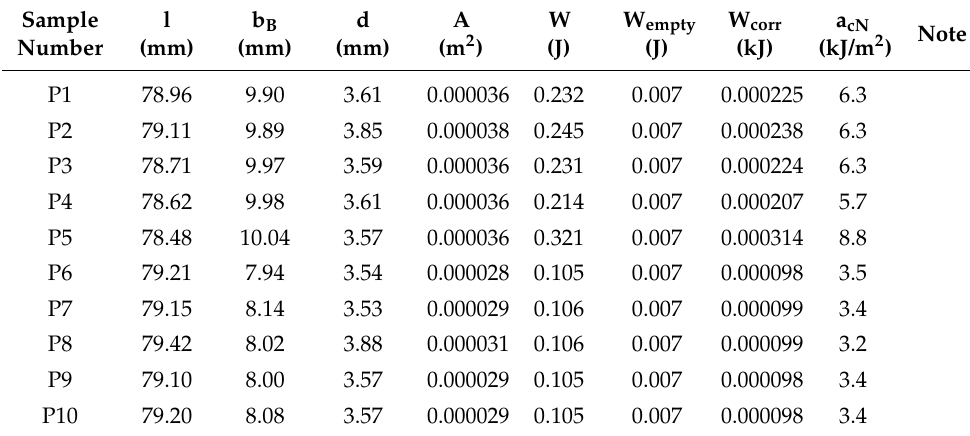
Table A21. Results of the notched impact tests and unnotched impact tests of PO_A,W,C.